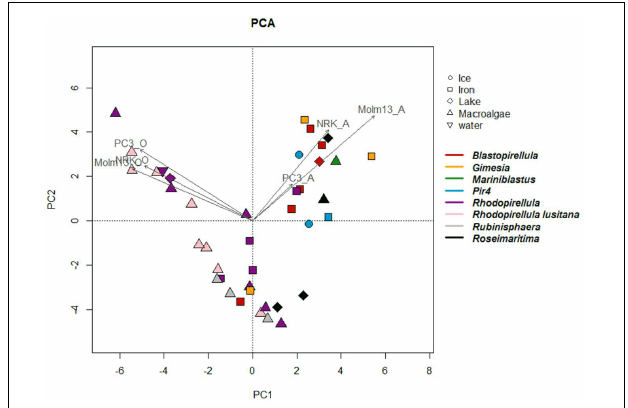
FIGURE 3 | Principal component analyses (PCA) constructed from a distance matrix based on the effect of the individual strains on the different cell lines. The figure illustrates the relationship between strains, their phylogenetic affiliation, their original environment and activity against the different cell lines in aqueous and organic phases. Axis 1 and 2 explains 50 and 23% respectively of the observed variance. Arrows indicate the correlation between strains and activity against cell